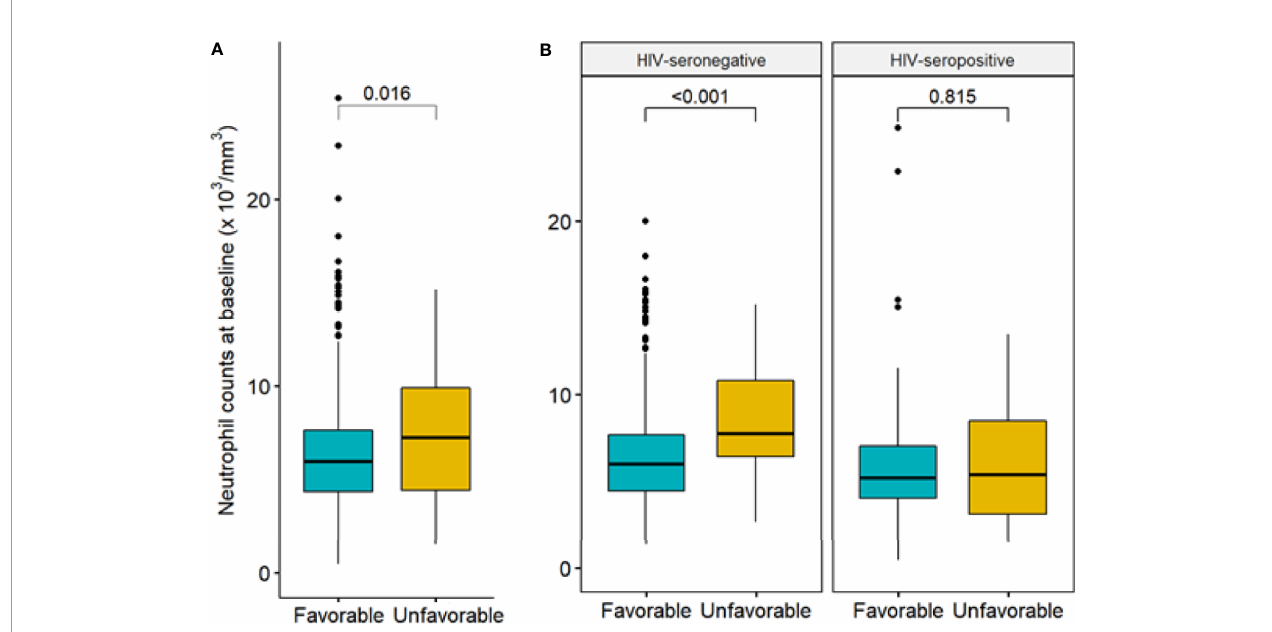
FIGURE 1 | Neutrophil count at baseline by treatment outcome. (A) Comparison of neutrophil count at baseline by treatment outcome (favorable/unfavorable, among N=691 patients); (B) comparisons of neutrophil count by treatment outcome, strati fi ed by HIV status (577 seronegative patients, with 34 unfavorable outcome, and 114 seropositive patients, with 22 unfavorable outcome). Favorable treatment: cure or treatment completion. Unfavorable treatment: death, failure, recurrence. P-value computed via Wald